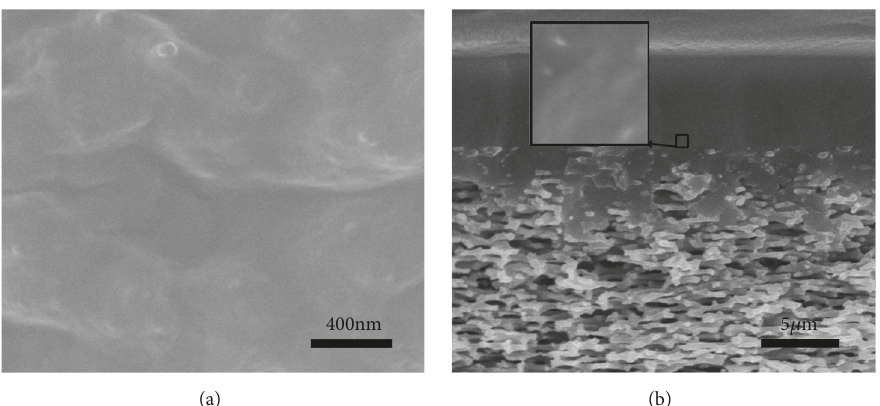
Figure 3: SEM images of (a) surface and (b) cross-section of PDMS hybrid membranes filled with 4 wt. % of APTS-SiO 2 .